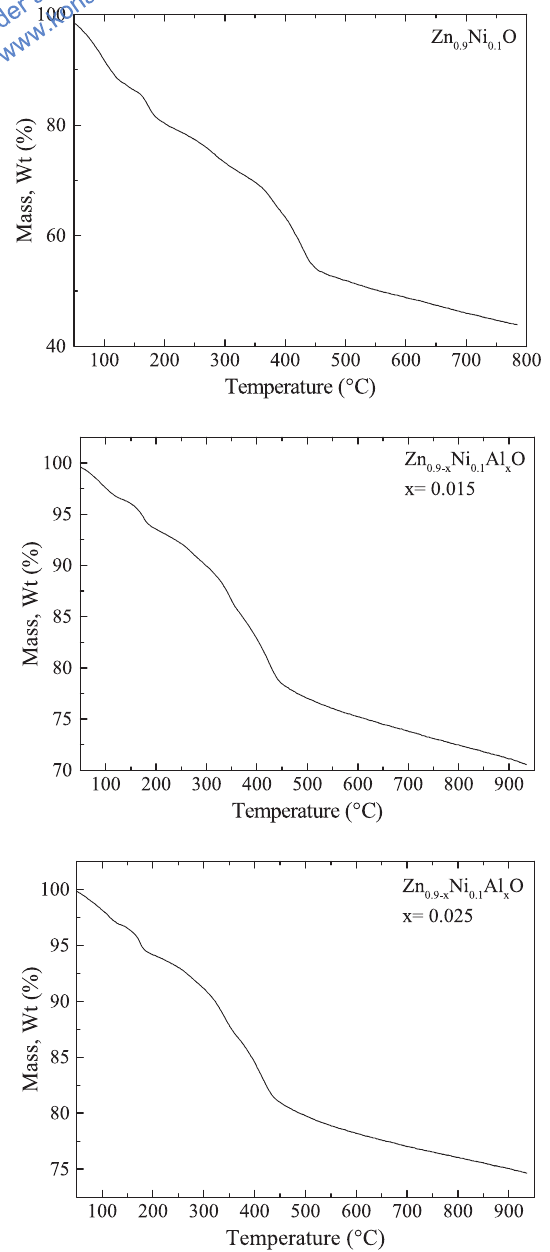
Fig. 5 TGA curves of nanosized Zn 0.9-x Ni 0.1 Al x O powders at a heating rate of 10°C/min. (a) x = 0.00, (b) x = 0.015 and (c) x = 0.025.